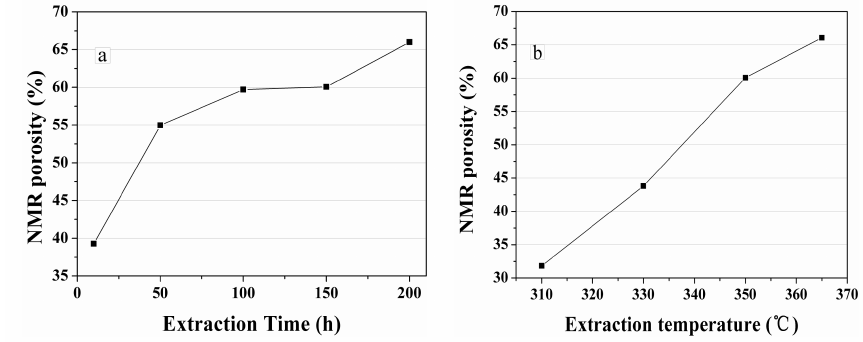
Figure 13. Porosity of spent shale samples after ( a ) 350 ◦ C and ( b ) 150 h sub-critical water extraction determined using